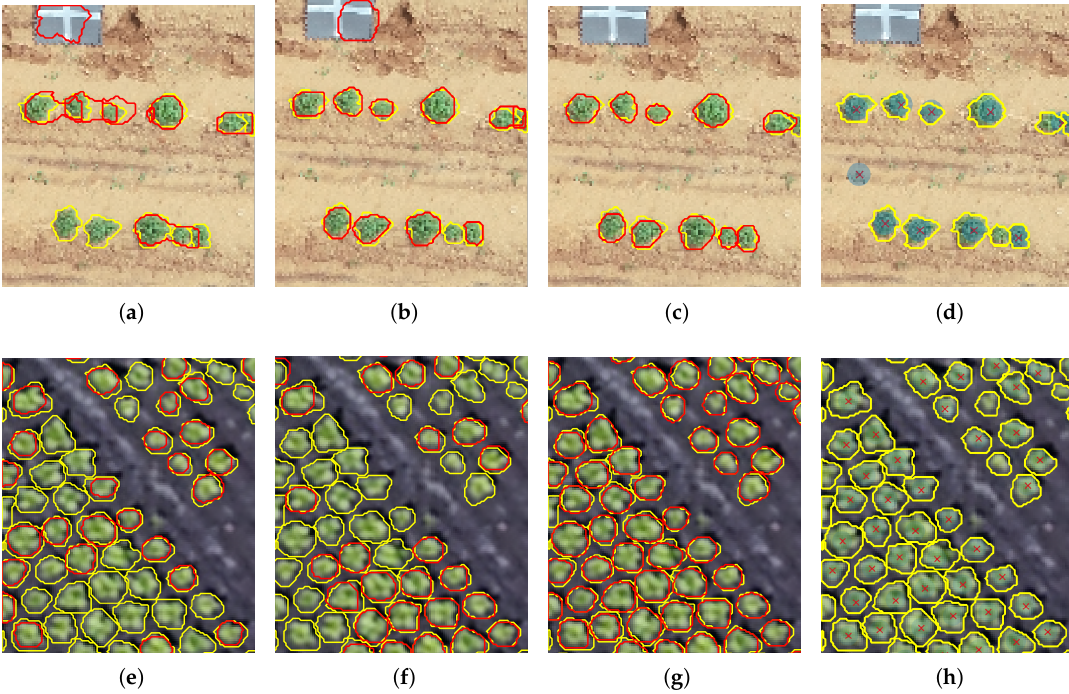
Figure 6. Predictions of the Mask R-CNN and Computer Vision (CV) methods. Yellow boundaries depict the groundtruth masks, red boundaries represent the predicted masks of the Mask R-CNN model, and red crosses surrounded by blue disks are the predictions of the computer vision method for plant centers. Samples shown are a subset of the entire image of spatial size 256 × 256 for visualization purpose but metrics computed stand for the whole image. In first row, one cropped sample image from POT_RTe is shown: ( a ) M1_POT; ( b ) M2_POT; ( c ) M3_POT; ( d ) CV. In the second row, one cropped sample image from LET_RTe is shown: ( e ) M3_POT; ( f ) M1_LET; ( g ) M2_LET; ( h )